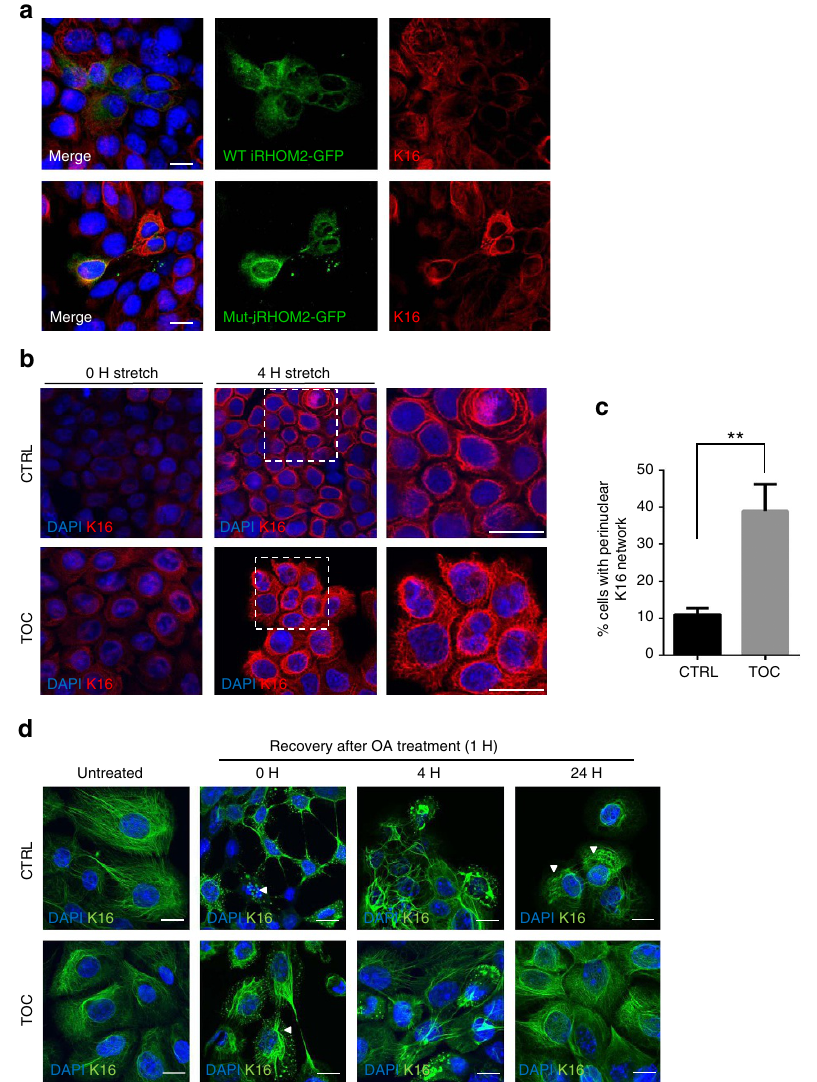
Figure 4 | iRHOM2 regulates the reorganization and dynamicity of K16 filaments. ( a ) CTRL keratinocytes were transfected with either WT-iRHOM2- GFP or TOC Mutant-iRHOM2-GFP and immunostained for endogenous K16 and analysed by confocal microscopy. Scale bar, 20 m m. ( b ) CTRL and TOC keratinocytes were subjected to cyclical mechanical stretch at a frequency of 5Hz and amplitude 10–13% using Flexcell FX-4000 Tension system for 0 and 4h, respectively. Stretched cells were immunostained for K16 and analysed by confocal microscopy. White arrowheads indicate perinuclear K16 filaments reorganization. Scale bar, 20 m m. ( c ) Quantification of the perinuclear localization of K16 filaments in CTRL and TOC cells. Data represent the mean of 3 independent experiments, each experiment comprising 30 images per cell line. Error bars denote s.d. ** P o 0.01 (Student’s t -test). ( d ) Confocal analysis of CTRL and TOC keratinocytes treated with 1 m M OA for 1h, then fixed 4 and 24h following treatment and immunostained for K16. White arrowheads represent aggregated K16 filaments. Scale bar, 20 m